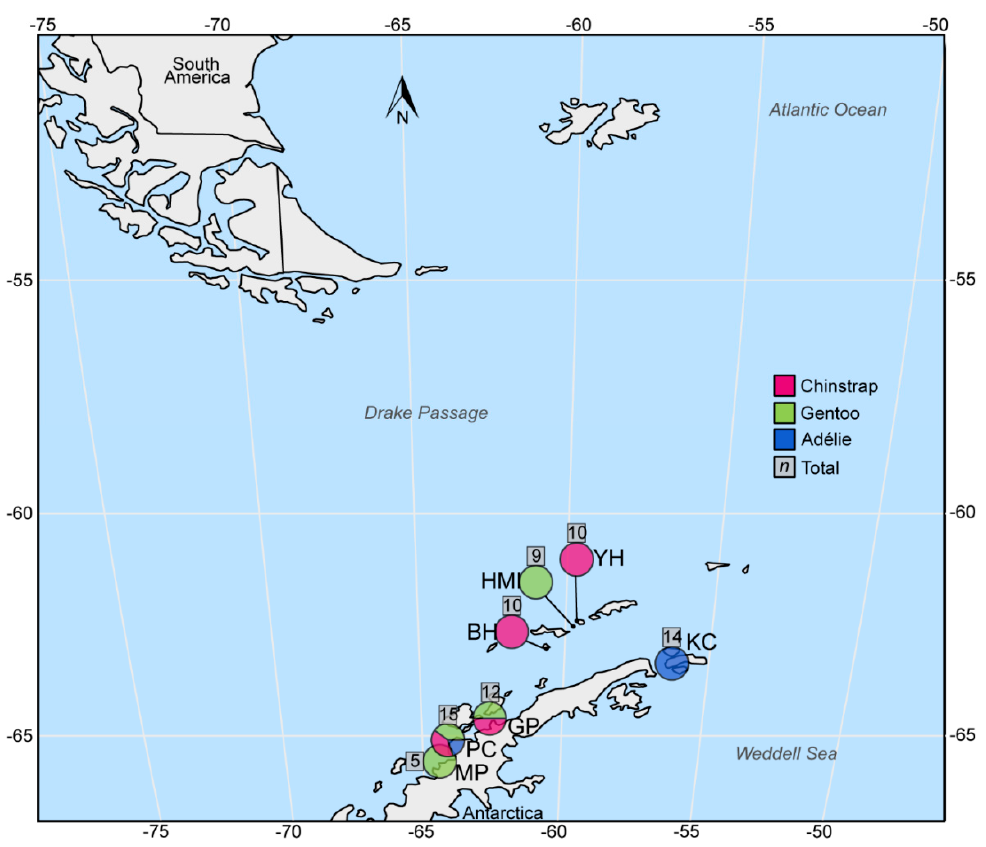
Figure 1. Map of Pygoscelis species penguin colonies sampled along the South Shetland Islands and Western Antarctic Peninsula, with pie chart colors representing the species sampled at each site. The grey boxed number associated with each pie chart reflects the total number of swabs obtained at the site. Site abbreviations: Half Moon Island (HMI); Yankee Harbor (YH); Baily Head (BH); Kinnes Cove (KC); Georges Point (GP); Port Charcot (PC); Moot Point (MP) as in Table 1.